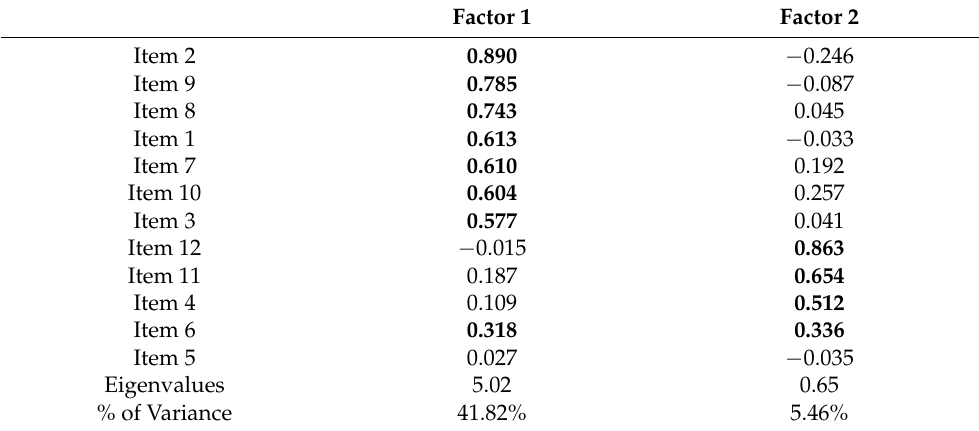
Table 4. The pattern matrix for the principal axis factor analysis on all of the GHQ-12 items. Factor 1 Factor 2 Item 2 0.890 −